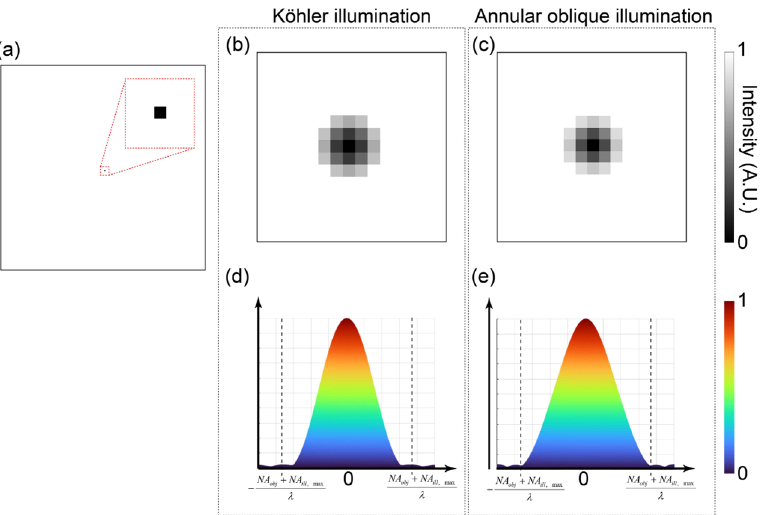
Figure 8. The simulated sample, PSF, and MTF, where ( a ) is a small strong absorption sample; ( b ) is the PSF for Köhler illumination; ( c ) is the PSF for annular oblique illumination; ( d ) is the cross section of MTF for Köhler illumination; ( e ) is the cross section of MTF for annular oblique illumination.